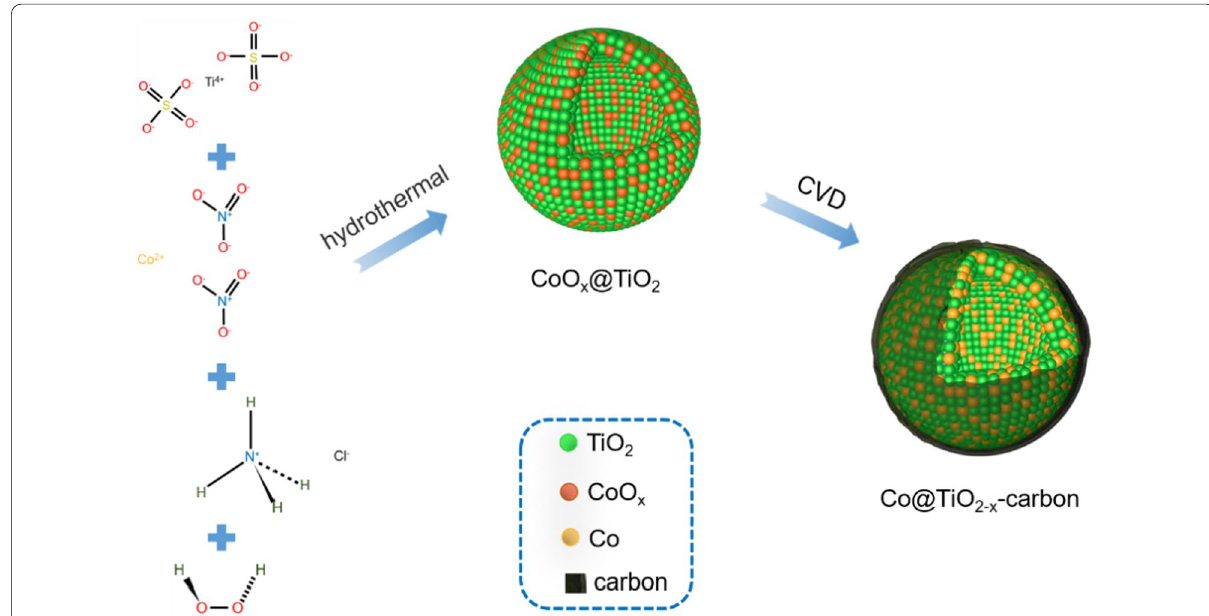
Fig. 1 Synthesis strategy of hollow Co@TiO 2